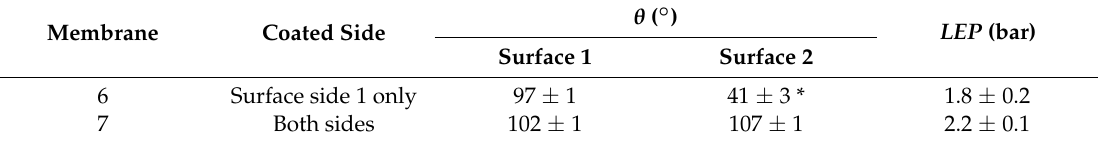
Table 6. Contact angle and LEP of the coatings applied by the spray system.